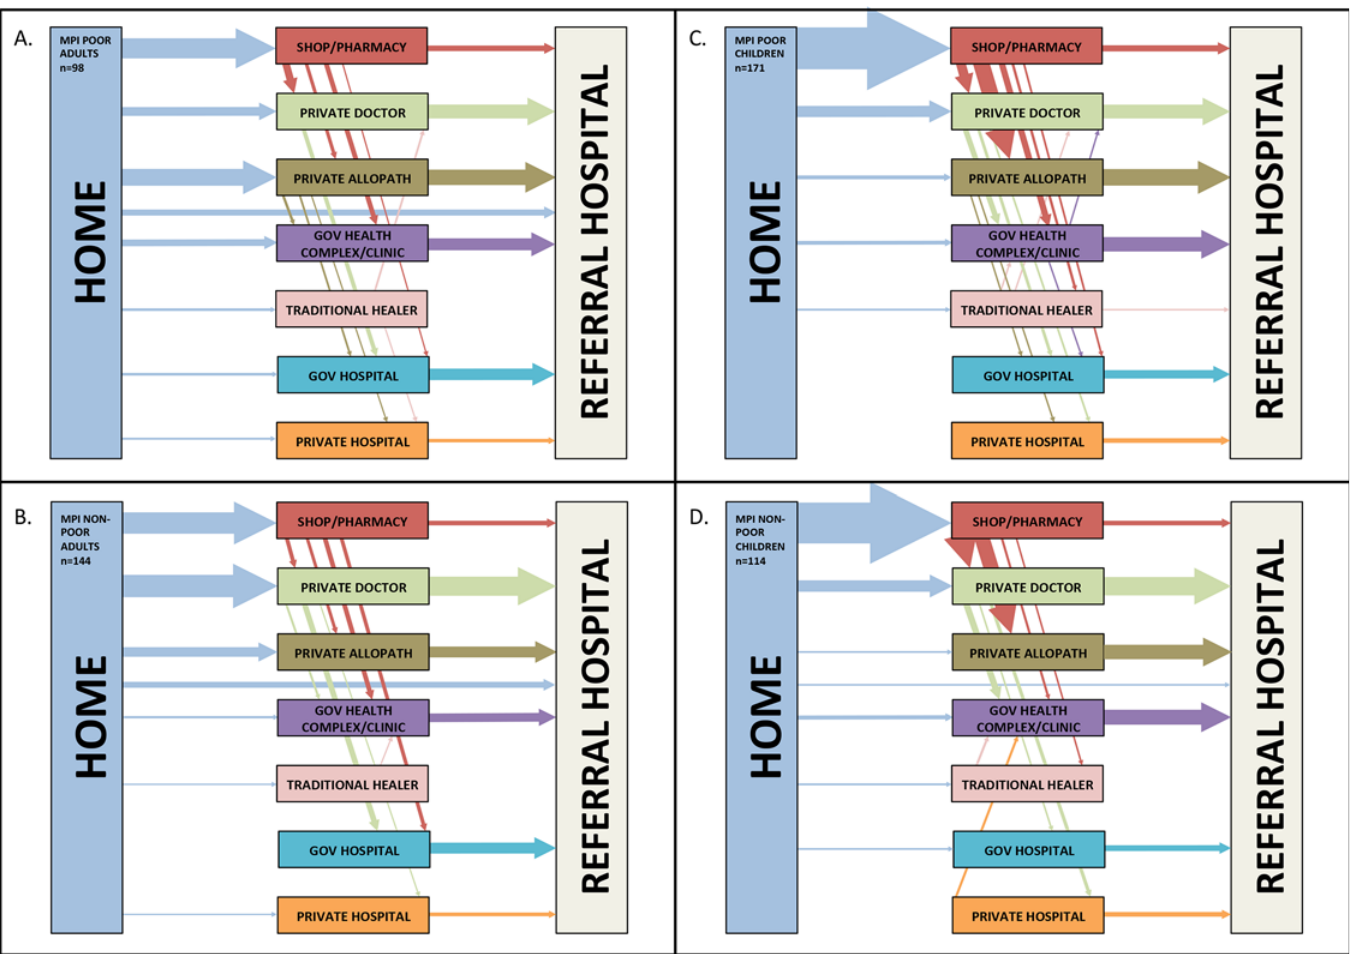
Fig 3. Patterns of care-seeking among participants prior to referral hospital admission. Patterns among MPI poor adults (A.), MPI non-poor adults (B.), MPI poor children (C.) and MPI non-poor children (D.). Arrows represent transitions between providers. Arrow sizes are proportional to the number of participants making a transition between each pair of care providers, and ordered by frequency from top to bottom for the transitions between home and initial source of help, and by frequency from left to right for transitions between sources of help consulted prior to the referral hospital. Transitions undertaken by fewer than 2% of the group are not